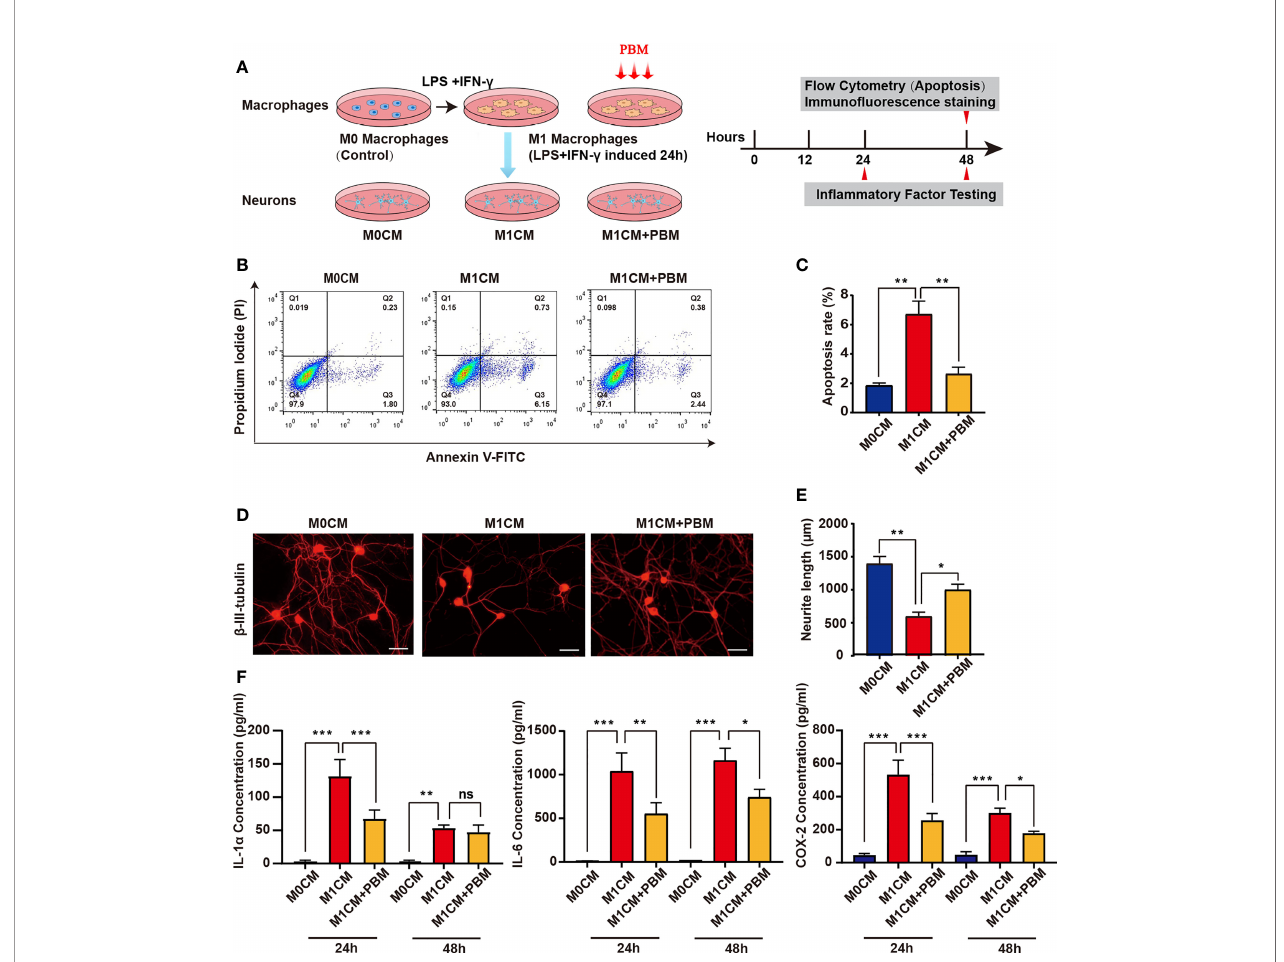
FIGURE 3 | PBM attenuates the neurotoxic effects of M1 macrophages on neurons. (A) Schematic diagram of the experiments with macrophages and neurons in pipette coculture. Timeline of the experiments conducted. (B) VSC 4.1 motor neurons were treated with M1 macrophage-conditioned medium (M1CM) for 24 hours, followed by double staining with Annexin V-FITC/PI and fl ow cytometry to detect apoptosis rates. Quadrant 3 (Q3) represents cells stained mainly by Annexin-V (early apoptotic cells), and Q2 represents cells stained by both PI and Annexin-V (late apoptotic). Q1 represents cells stained mainly by PI, and viable cells negative for both Annexin-V and PI appear in Q4. (C) The apoptosis rate of neuronal cells is shown in the bar graph. (D) Representative images of b -III-tubulin + cultured DRG neurons (n=3 independent experiments for neurite outgrowth assays, scale bars=50 m m). (E) A quanti fi cation graph of the mean neurite length per neuron in each group. (F) ELISA was used to detect the concentration of in fl ammation-associated cytokines in macrophage-conditioned culture media (all experiments in this group were independently repeated three times). *P < 0.05, **P < 0.01, ***P < 0.001; ns, not signi fi